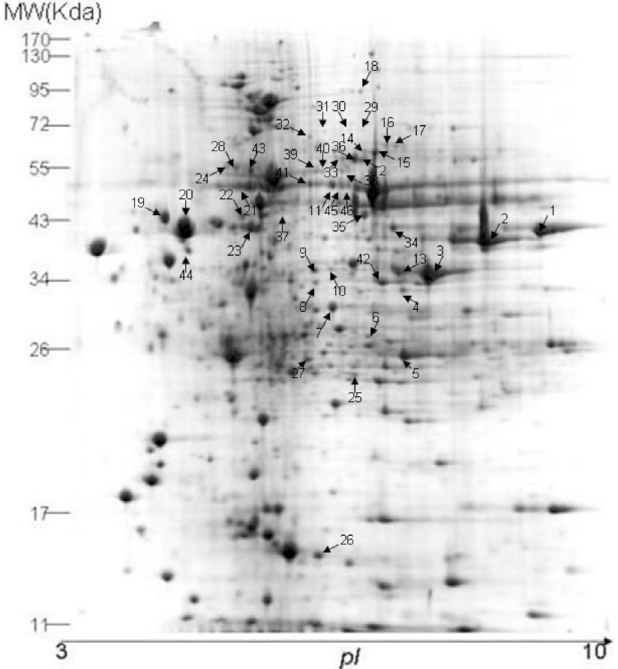
Figure 1. Identi fi cation of proteins of unsporulated E. tenella oocysts by 2-D gel electrophoresis. Isoelectro-focusing was performed with 600 m g protein for 50kVh using a pI 3-10strip. SDS-PAGE was performed on a 12.5% gel and then stained with CBB. Numbers are used to mark the spots analyzed.